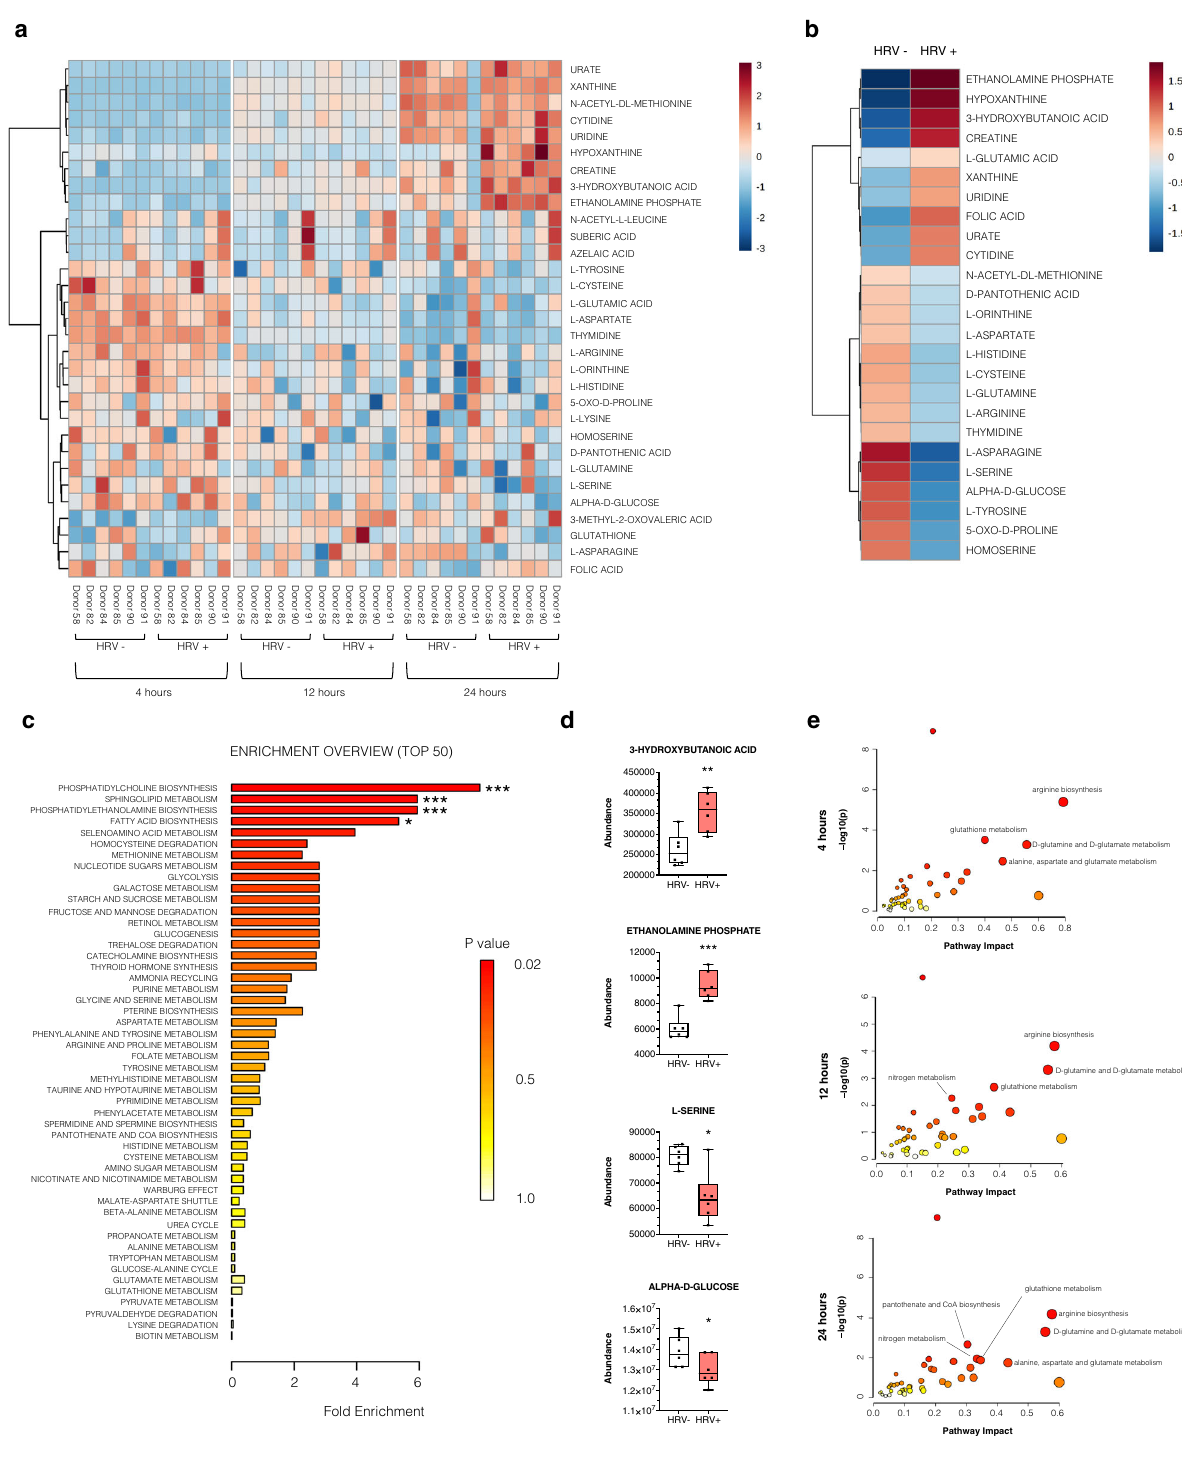
mRNA were induced during the 4-h post-infection window of elevated oxygen consumption, high ROS activity, and intact barrier function. Because HRV-C15 downregulates PGC-1 α by 8 – 12 h post infection, we investigated the effect of oligomycin A on the expression of either HK2 or PPARGC1A and observed that it markedly increases PPARGC1A expression (Fig. 5e). In light of this observation, we investigated the relationship between ROS and PPARGC1A expression and potential PGC-1 α involvement in regulating barrier function. Scavenging mitochondrial ROS using MitoTEMPO lowers PPARGC1A mRNA expression (Fig.